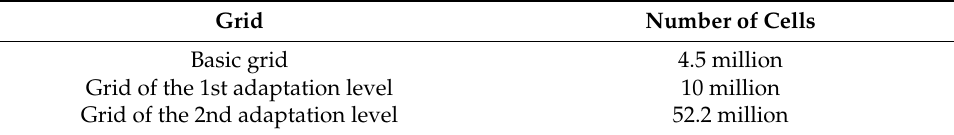
Figure 27. Normalized variation of static pressure (LM1021).